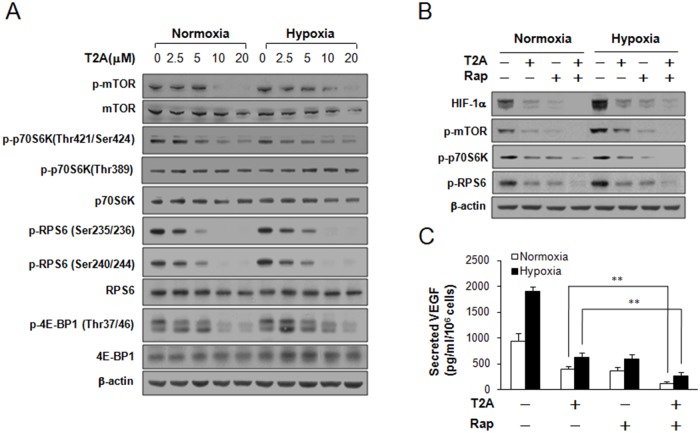
The mTOR/p70S6K/ RPS6/4E-BP1 signaling pathway was involved in T2A-induced inhibition of HIF-1α.(A) The MDA-MB-231 cells were treated without or with various concentrations of T2A for 24 hours under normoxic and hypoxic conditions. Whole cell extracts were prepared from cells and subjected to Western blot assay using antibodies against phospho-mTOR (p-mTOR), mTOR, p70S6 Kinase(p70S6K), p-p70S6K (Thr421/Ser424), p-p70S6K(Thr389), S6 Ribosomal Protein (RPS6), p-RPS6(Ser235/236), p-RPS6(Ser240/244), 4E-BP1, and p-4E-BP1(Thr37/46). (B) Cells were pretreated with rapamycin (20 nM) for 2 hours, followed by T2A treatment (20 μM) under normoxic or hypoxic conditions as described above. Whole cell extracts were analyzed by Western blot using antibodies as indicated. (C) VEGF in the supernatant was evaluated using ELISA. Error bars represent means ± SD (n = 3). Values of cells treated with T2A and rapamycin were significantly reduced compared to values obtained from cells treated with T2A alone based on Student’s t-test; **P <0.01.